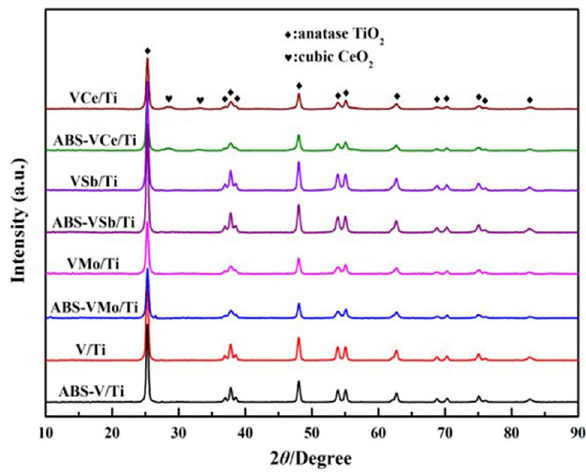
Figure 3. XRD spectra of different catalysts before and after loading ABS 4 .